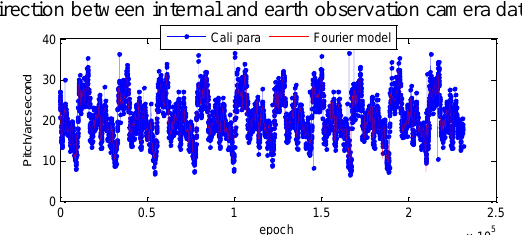
Figure 9. Chart of conversion parameters variation in pitch direction between internal and earth observation camera datum Figure 6. Chart of conversion parameters variation in pitch In order to effectively eliminate the influence of the periodic direction between AB and BC datum variation of the conversion parameters between the internal datum and camera datum on the image geometric accuracy, this paper also uses the fourier series model to fit the conversion parameters, and the fitting results are consistent with the observed results. Table 1 and 2 respectively do statistics on geometry accuracy changes of panchromatic images before and after low frequency error compensation, and the statistical results show that the geometric positioning accuracy under no control point of panchromatic image is about 70 meters before low frequency error compensation, about 40 meters after compensating, and the overall results increases by about 40%.